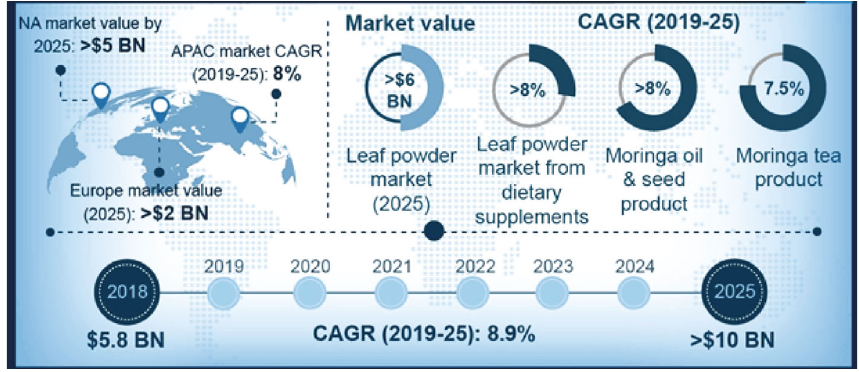
Figure 1: Moringa ingredient